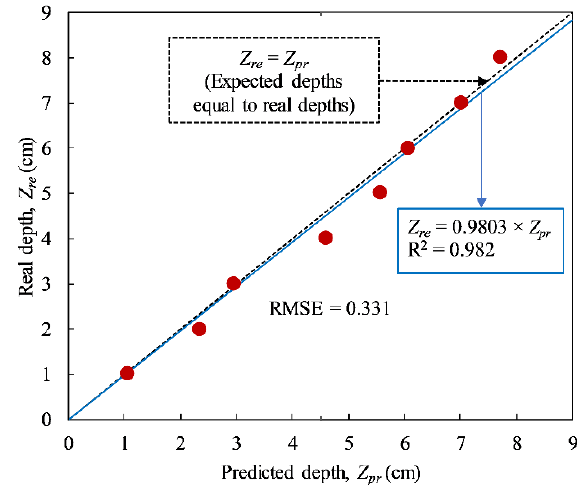
Figure 11. Prediction of delamination depths in CSC structure under all cases of heating times.